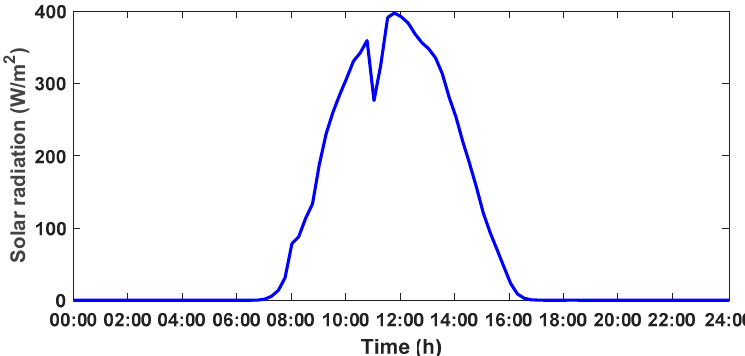
Figure 13. The outside temperature of the CSG on 26 January 2018.